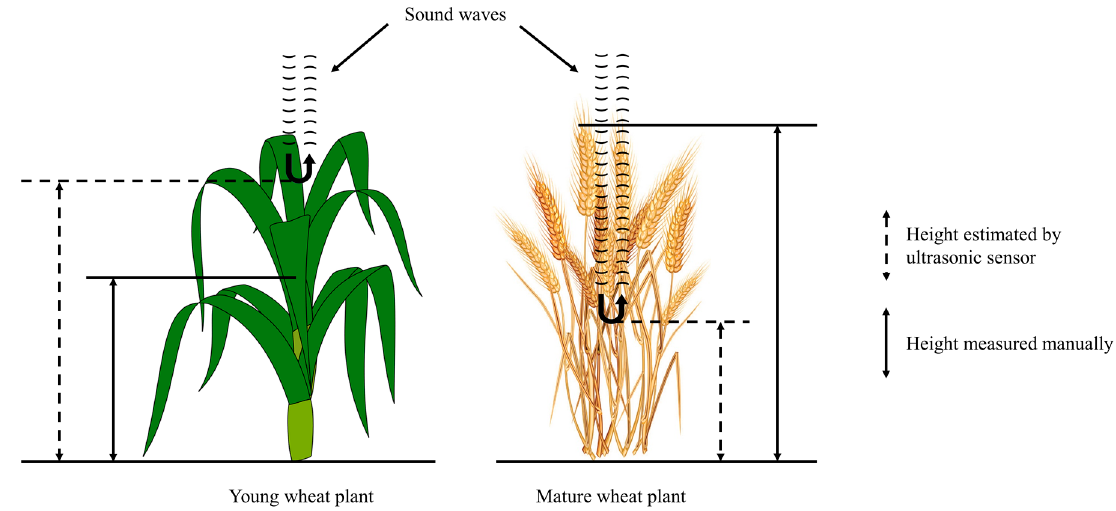
Figure 10. Two scenarios where ultrasonic sensor estimations disagree with manual measurements.